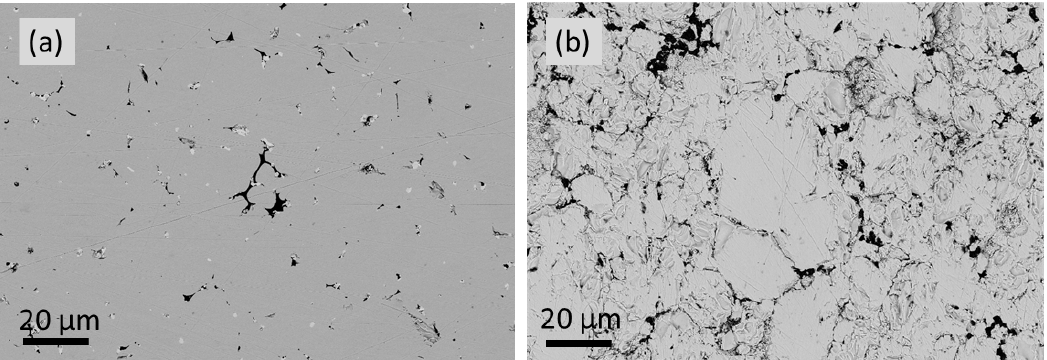
Figure 17. The microstructures of ( a ) 0.5 GAlN and ( b ) 3 GAlN composites after thermal cycling. As seen, the bulk of 0.5 GAlN consists of slightly coarser grains comparing to the one after sintering. The overall structure remains the same. At the same time structure of 3 GAlN composites after thermal cycling changes considerably. The evolution of grains from elongated to close-to-cubic shapes is observed. Latter results in the distortion and partial breakup of the GAlN network. Besides, the composites were studied by STA. The